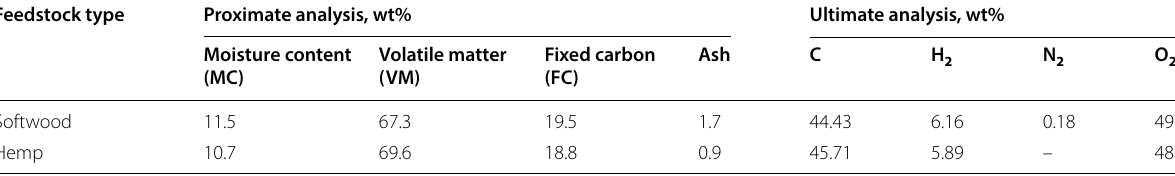
Table 1 Proximate and ultimate analysis of raw feedstocks Feedstock type Proximate analysis, wt%